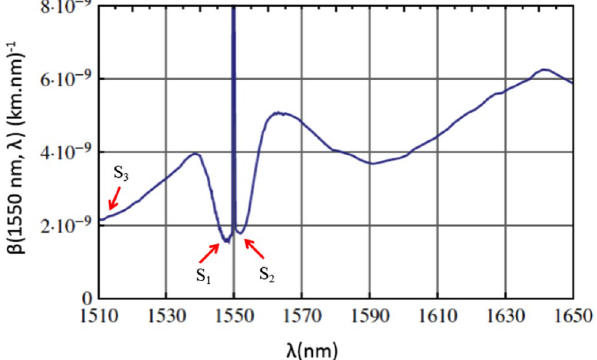
Figure 3. Measured Raman cross section with respect to a central wavelength of 1550 nm in a standard single mode fiber 26